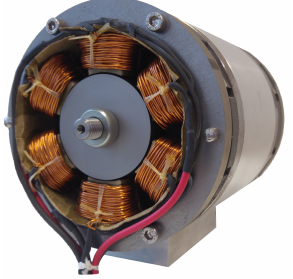
Figure 4. Prototype of a self-sensing radial homopolar active magnetic bearing with six poles. The bias flux of the bearing is realized by the use of permanent